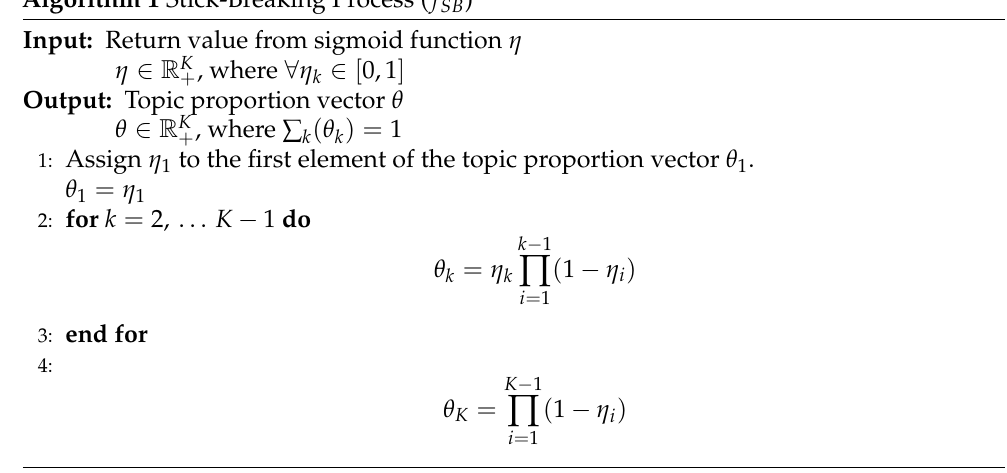
Algorithm 1 Stick-Breaking Process ( f SB